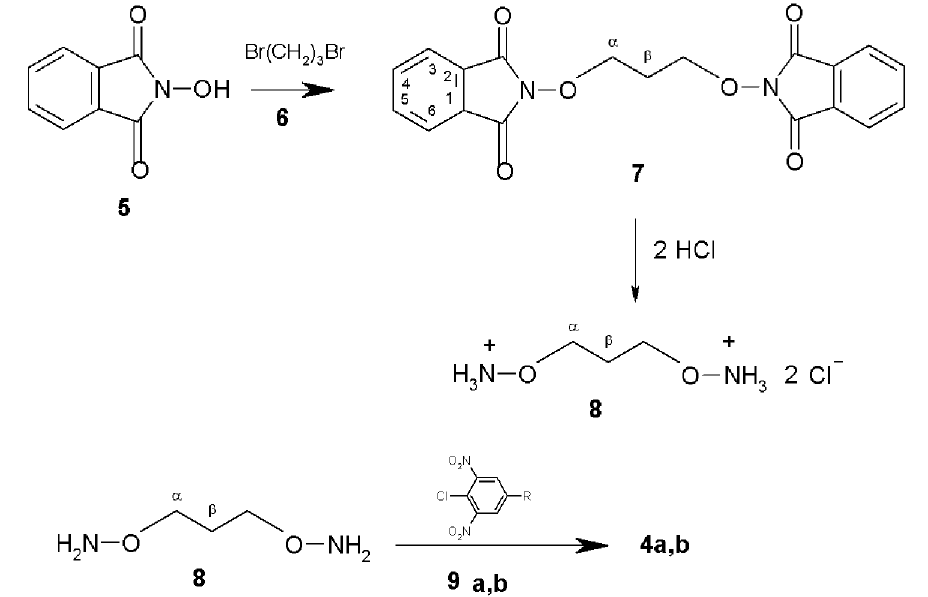
Fig. 1 Synthesis of compounds 4a,b